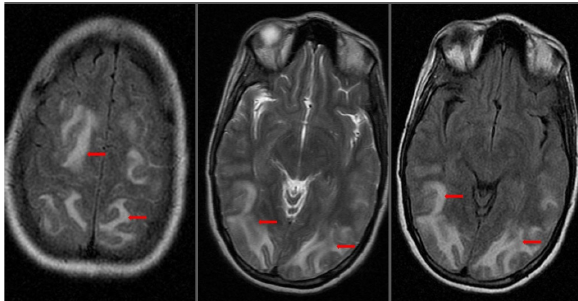
Figure . 3. Brain MRI showing symmetrical cerebral vasogenic edema bilaterally involving the occipital, parietal and posterior parts of frontal lobes (Red Arrows), picture highly indicative of